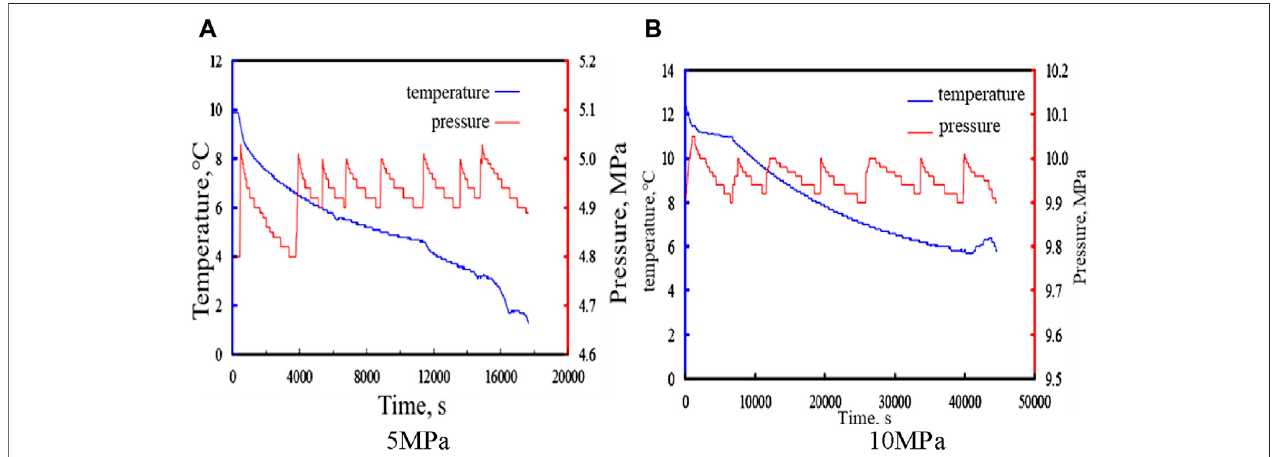
FIGURE 9 | Variation of temperature and pressure at 7% inhibitor concentration. ( A :5 MPa; B :10 MPa).